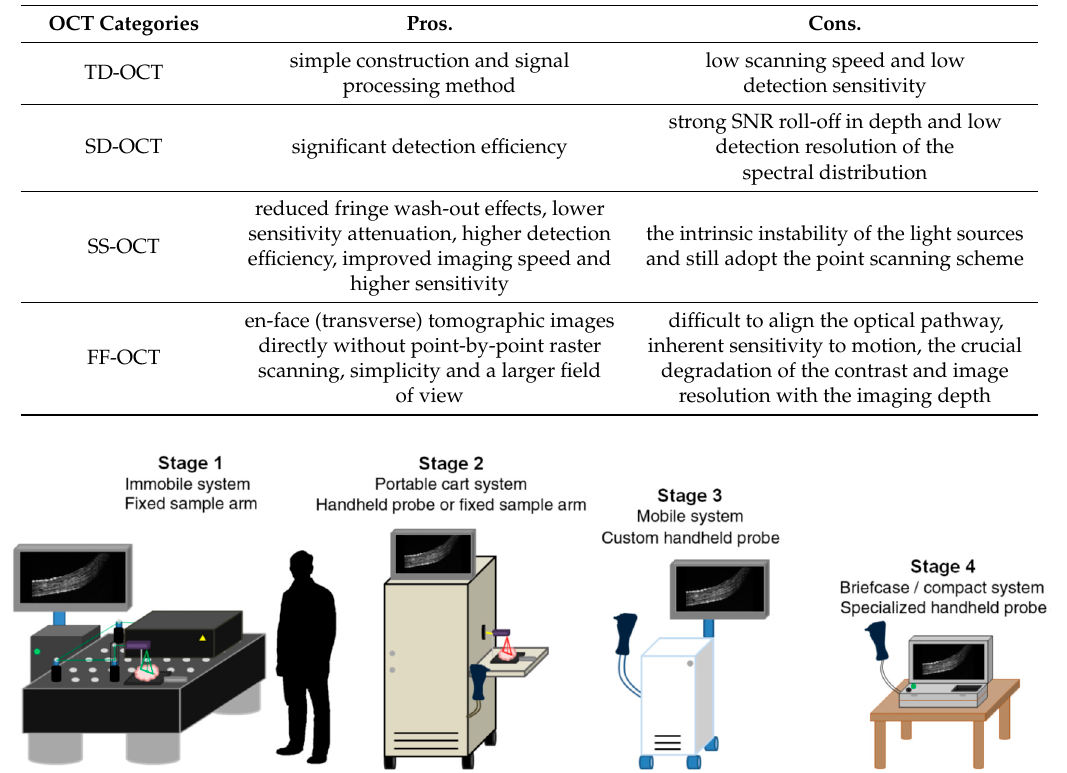
Table 1. The pros and cons of the di ff erent categories of OCT.